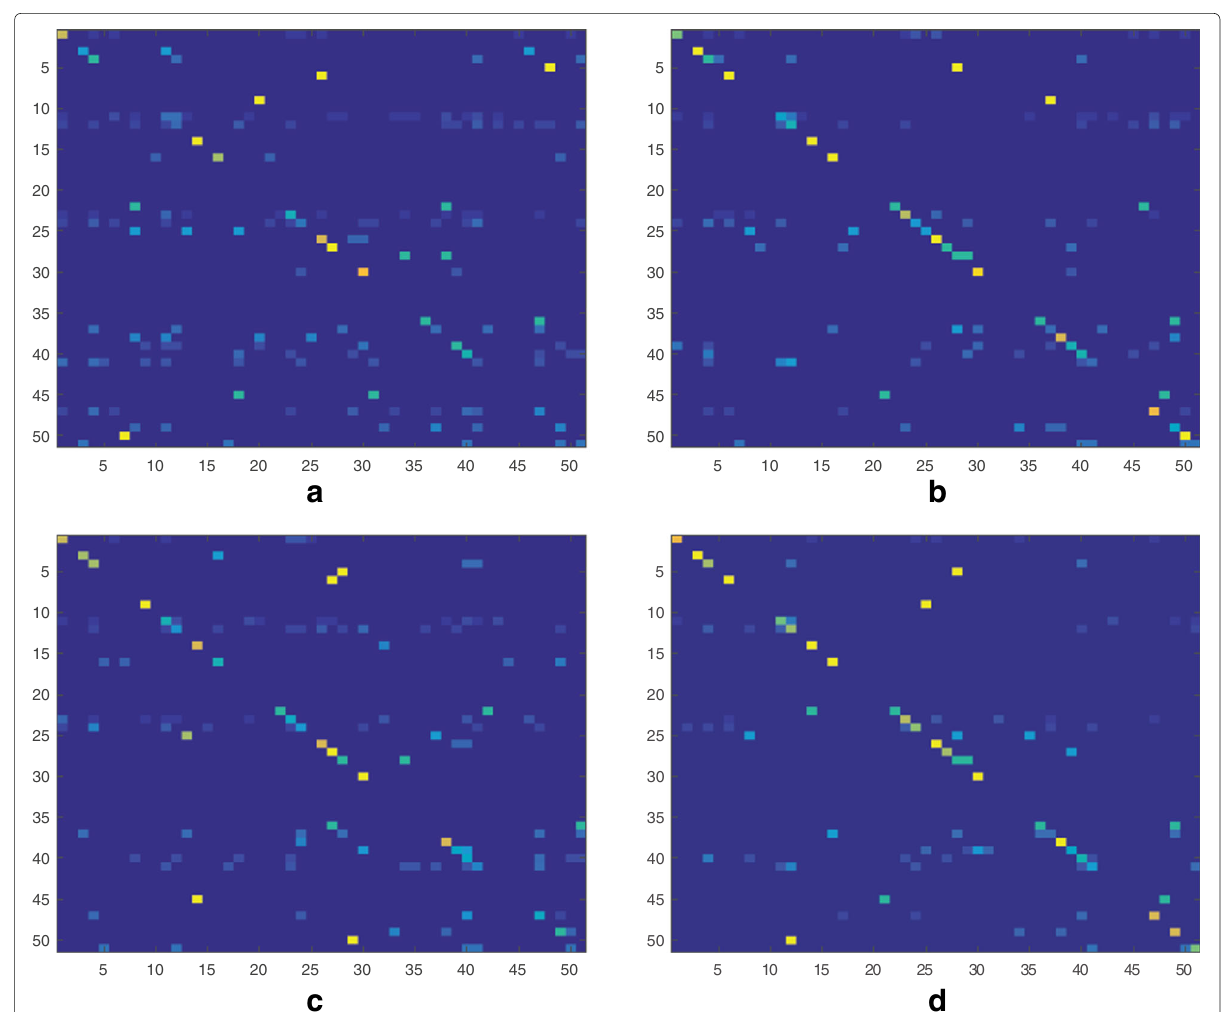
Fig. 11 Confusion matrices of the first split of HMDB dataset. Confusion matrices on the right side show the effects of fusing BSIF-TOP textural features with STIP and iDT features. a STIP. b STIP+BSIF-TOP. c iDT. d